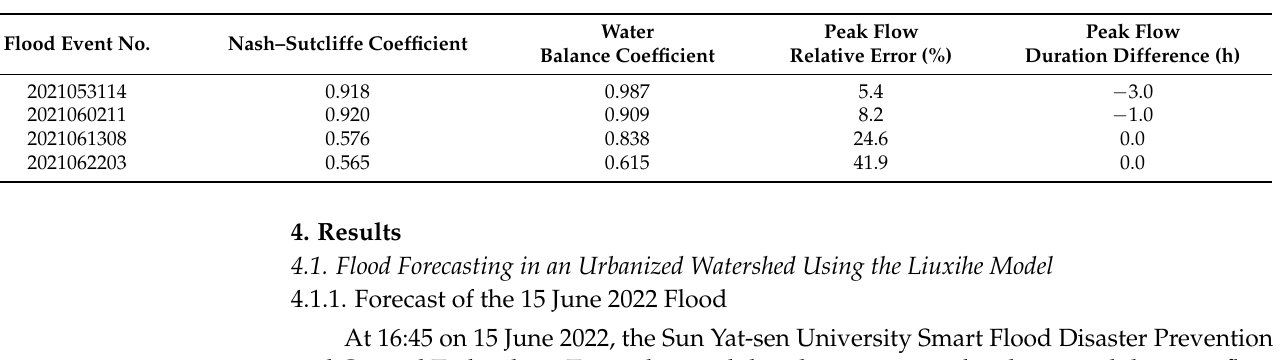
Figure 8. Parameter optimization and simulation processes for representative floods. ( a ) The param- eter optimization flood (No. 2021060211); and the simulation floods: ( b ) No. 2021053114, ( c ) No. 2021061308, and ( d ) No. 2021062203. Table 5. Statistical indicators of flood simulation results after the optimization of various Liuxihe model parameters.